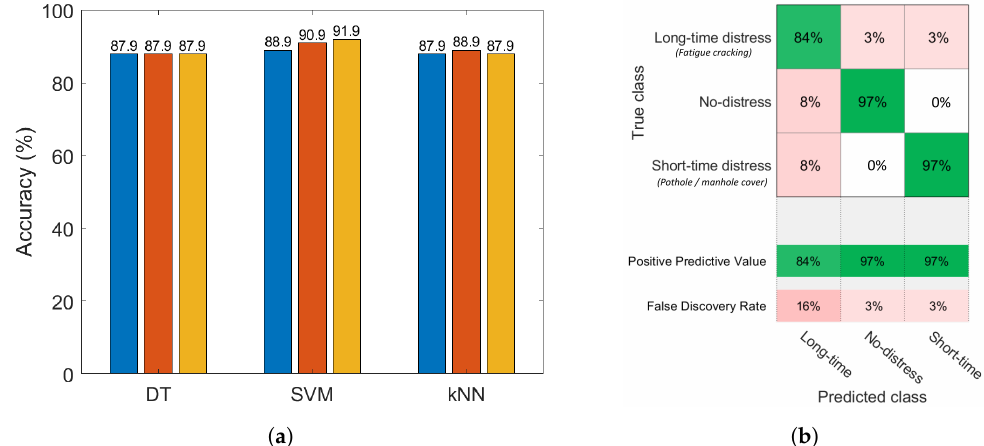
Figure 11. Classification results based on data collected from the car’s floorboard; predictive accuracy of the considered supervised learning classification families: DT (2, 5, 10 splits), SVM (linear, quadratic, cubic kernels), k NN (1, 10, 30 neighbours) ( a ); confusion matrix for the cubic SVM classifier ( b